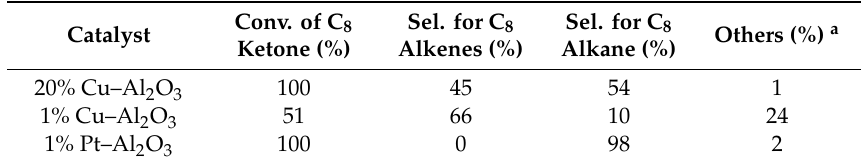
Table 2. Catalytic activity in the conversion of C 8 ketones to C 8 alkenes and C 8 alkane over several